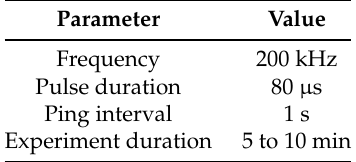
Table 6. Device setting used in experiments.